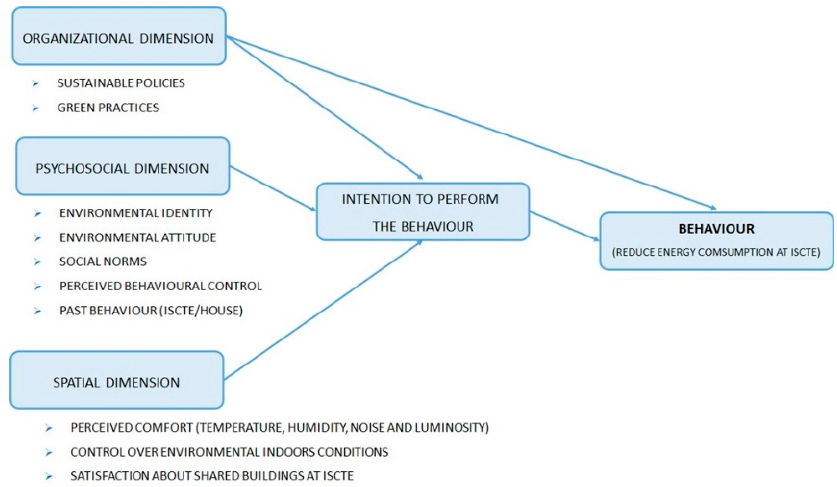
Figure 1. Behavior change diagnostic model for ISCTE’s community assessment.